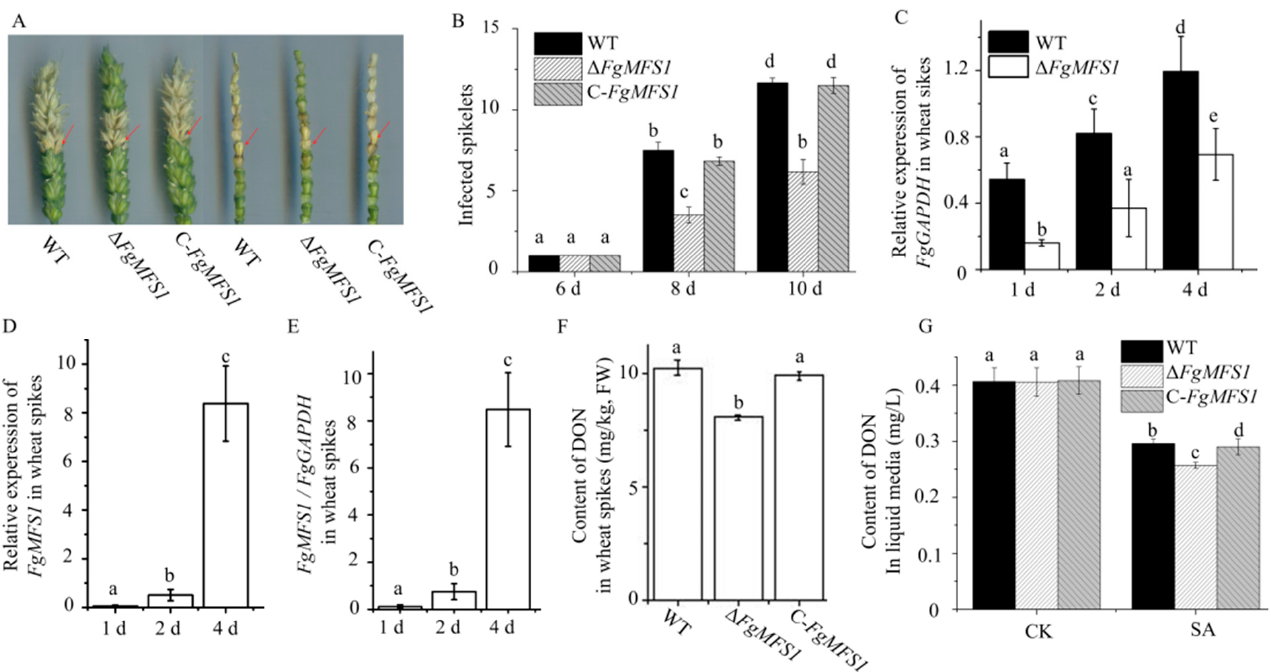
Figure 6. FgMFS1 is essential for full pathogenicity towards wheat. ( A ) Wheat heads and rachises, respectively, point inoculated with the WT, Δ FgMFS1, and C-FgMFS1 strains on the 8 th dpi. The red arrows indicate the inoculated spikelets. ( B ) Numbers of infected and bleached spikelets in wheat spikes, respectively, point inoculated with the WT, Δ FgMFS1 and C-FgMFS1 strains, on the 6 th , 8 th , and 10 th dpi. ( C ) Relative expression levels of FgGAPDH in spikes inoculated with the WT and Δ FgMFS1 strains on the 1st, 2nd, and 4th dpi, respectively. ( D ) Expression of FgMFS1 in spikes inoculated with the WT strain, on the 1 st , 2 nd , and 4 th dpi. ( E ) Ratio of the expression of FgMFS1 to that of FgGAPDH in wheat spikes inoculated with the WT strain, on the 1 st , 2 nd , and 4 th dpi. ( F ) Contents of DON in spikes inoculated with WT, Δ FgMFS1, and C-FgMFS1 , respectively. ( G ) Concentrations of DON in liquid media without (CK) and with 1 mM SA. Different letters above each column indicate significance at P < 0.05. FW, fresh weight.